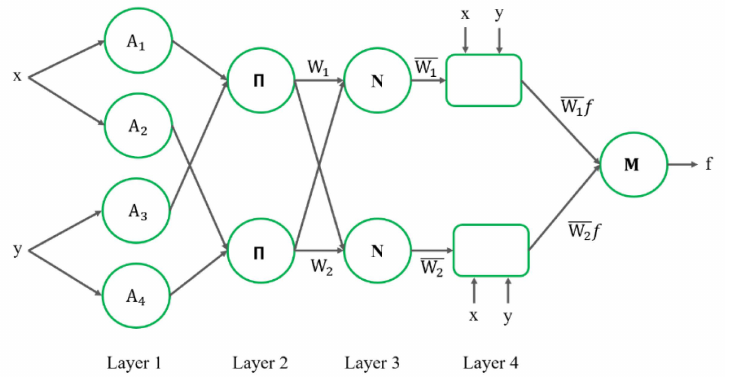
Figure 2. Schematic of an ANFIS